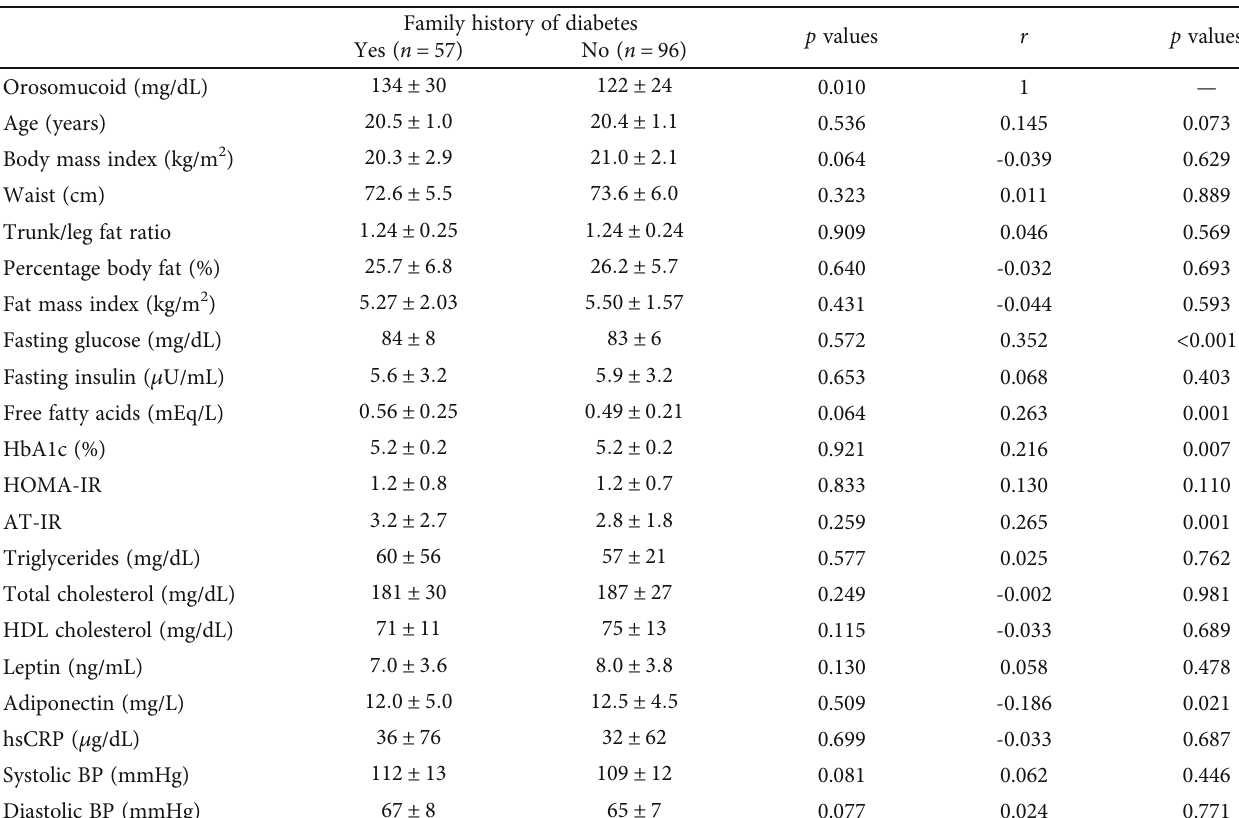
Table 1: Orosomucoid serum concentrations and other characteristics of 153 young Japanese women with and without a family history of type 2 diabetes and correlation coe ffi cient ( r ) of